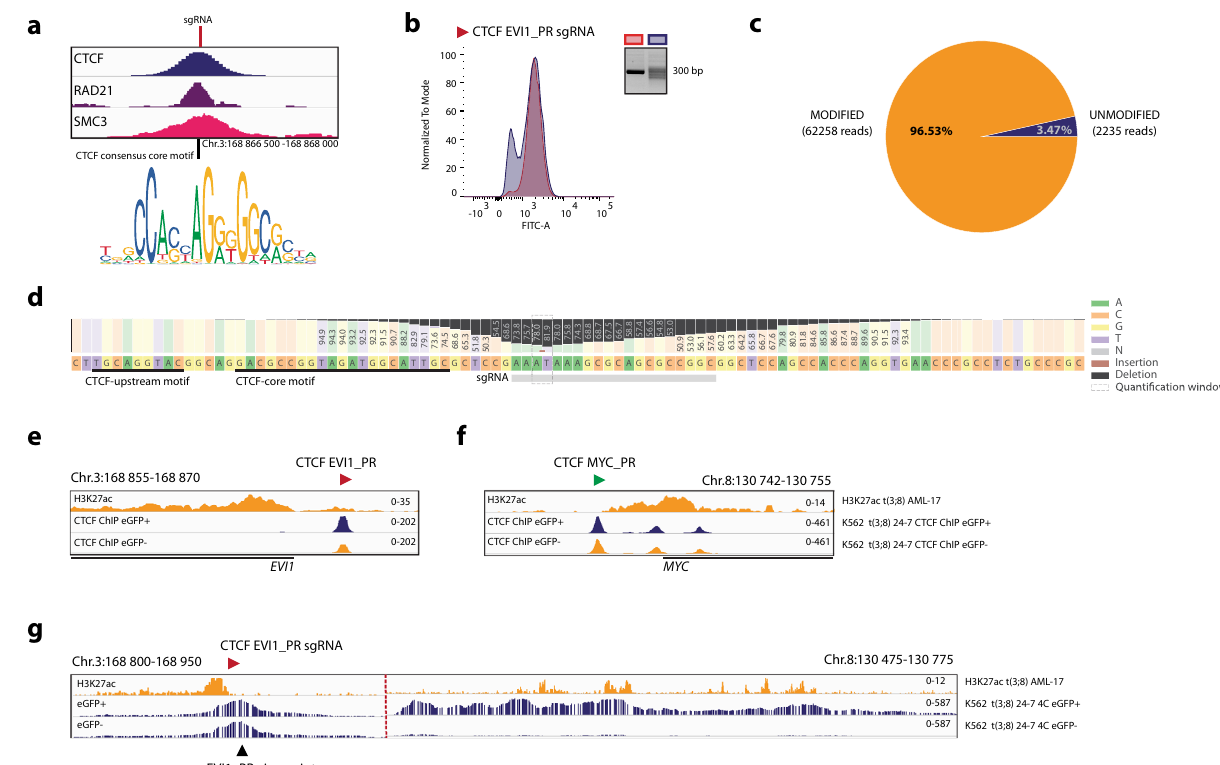
Fig. 6 CTCF binding site upstream of the EVI1 promoter hijacks a MYC SE in t(3;8) AML. a ChIP-seq data of CTCF (blue) and the cohesin subunits RAD21 (purple) and SMC3 (pink) in K562, with a zoom-in on the EVI1 promoter binding site. The vertical line indicates the exact cleavage site of the sgRNA and the CTCF motif as described by JASPAR 63 below. b Flow cytometry overlay plot after targeting the CTCF EVI1 _PR binding site by sgRNA (clone 8-4, blue graph) and in red the control cells (clone 8-4, no Cas9). On the right of the graph, the mutations introduced by the single sgRNA in the amplicon over the cutting site are shown by PCR. Source data are provided as a Source Data fi le. c Amplicon-seq data showing the percentage of modi fi ed (orange) and unmodi fi ed (blue) reads in the eGFP − sorted cell fraction after targeting CTCF EVI1 _PR. d Amplicon-seq data showing the mutations in the nucleotides around the Cas9 cleavage site, in the eGFP − sorted cell fraction after targeting CTCF EVI1 _PR with sgRNA. The bars and numbers indicate the percentage of reads found with the particular mutation, below the locations of the sgRNA (gray bar) and the CTCF motifs (black lines). e CTCF ChIP-seq presenting CTCF occupancy in the eGFP + (clone 24-7, blue), and eGFP − (clone 24-7, orange) fractions after targeting CTCF EVI1 _PR with the sgRNA. The top H3K27ac track (orange) indicates the presence of an active promoter. f The same CTCF ChIP-seq tracks as in e are shown, but here presenting unchanged CTCF occupancy at the CTCF binding site upstream of the MYC promoter. g Chromatin interaction at the MYC SE for eGFP + and eGFP − cells (clone 24-7), shown by 4C-seq with the EVI1 promoter as viewpoint after targeting the CTCF motif with the